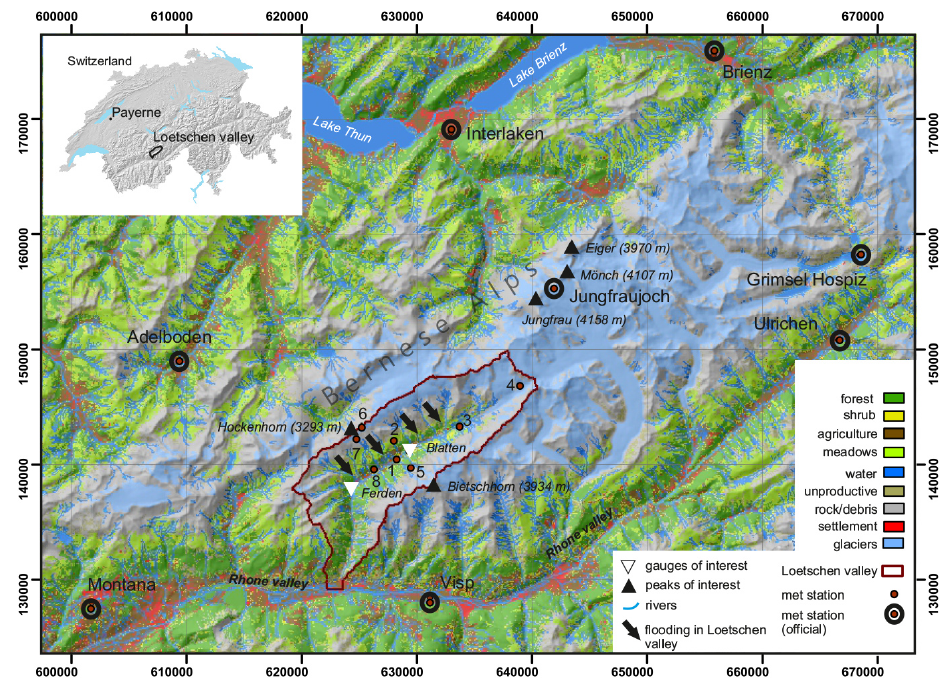
Figure 1. Location of the Lötschen Valley in Switzerland and the land cover characteristics of the valley. The black arrows indicate the flooding rivers, red dots and black circles represent meteorological stations and white triangles represent discharge gauges. Recordings from the meteorological stations in the Lötschen Valley will be analyzed in Sect. 3.2. The stations’ names are (1) Ried, (2) Chumme, (3) Grund, (4) Grossi Tola, (5) Mannlich, (6) Sackhorn, (7) Gandegg, and (8) Wiler.